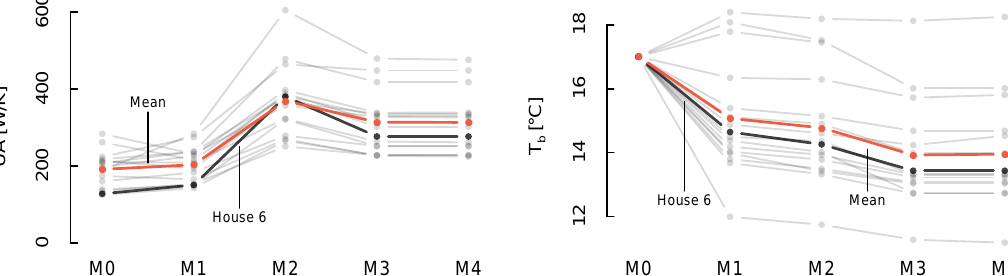
Figure 5. Slope chart of UA value ( left ) and base temperature T b ( right ) of models M0–M4 obtained from 16 different houses. The left-side plot shows the UA values (i.e., the heat loss coefficients) under wind speed conditions corresponding to the mean wind speed observed in the measurement period (2.5m/s). The right-side plot shows the base temperature obtained by the different models for each of the 16